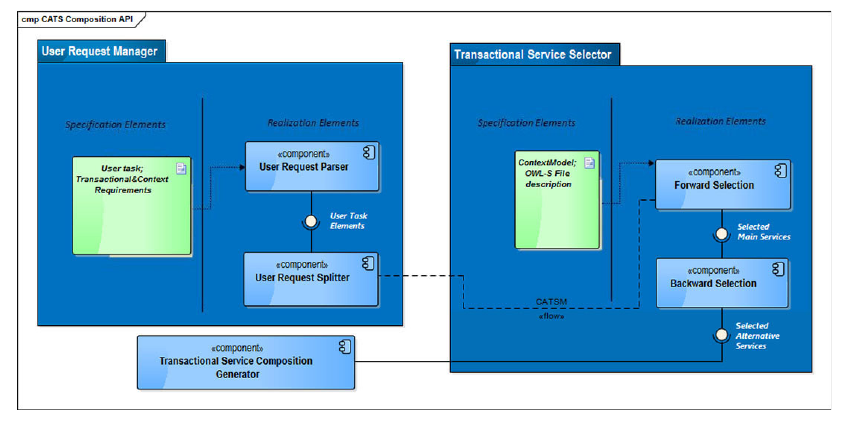
Fig. 3. CATS service composition